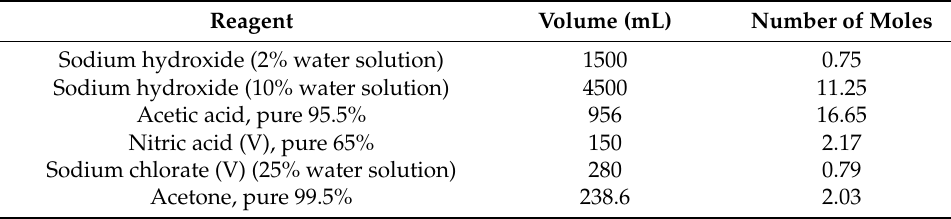
Table 2. Reagents used for NC